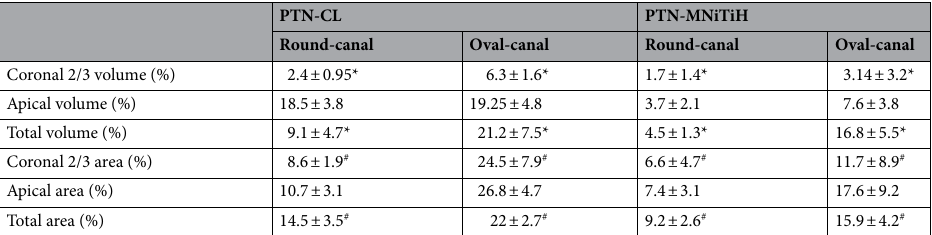
Table 1. Mean Percentage of Volume (mean ± standard deviation) and of Covered Canal Surface Area of RFMs in different canal shape groups. *indicates a significant difference between different canal shape groups of the volume of RFMs (independent-samples t test, P < 0.05). # indicates a significant difference between different canal shape groups of the covered canal surface area of RFMs (independent-samples t test, P < 0.05).